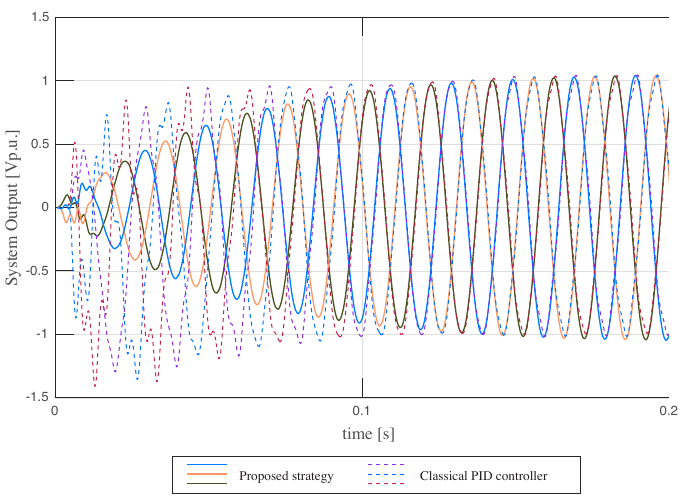
Figure 8. Comparing 3-phase output voltage of the proposed strategy vs. classical PID controller, in per-unit